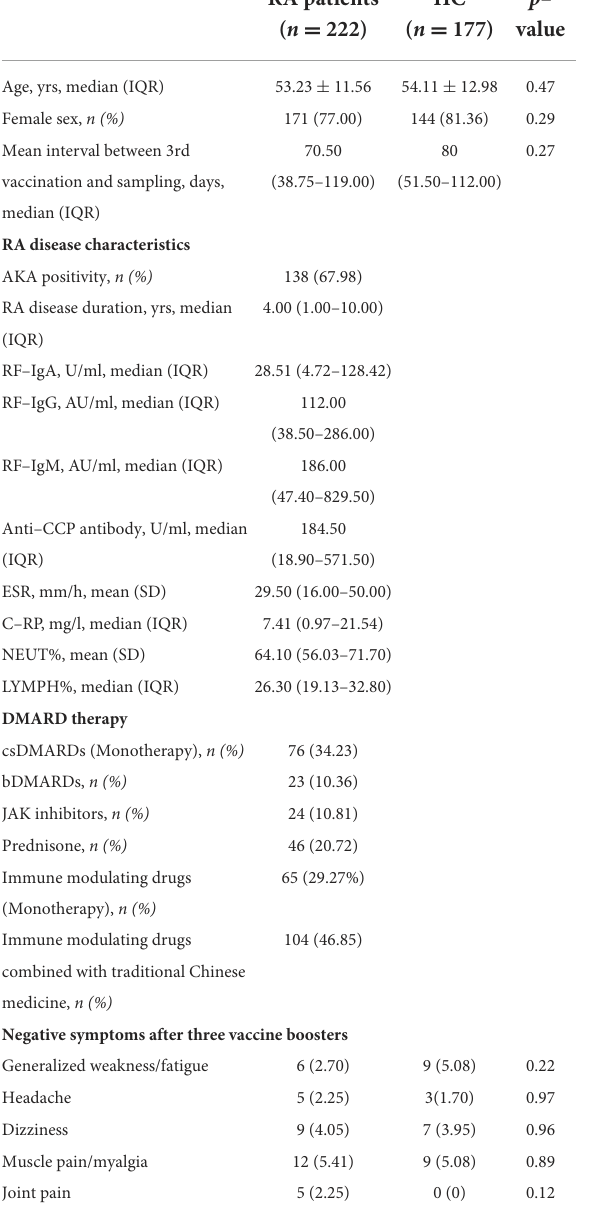
TABLE 1 Baseline characteristics of and RA patients and